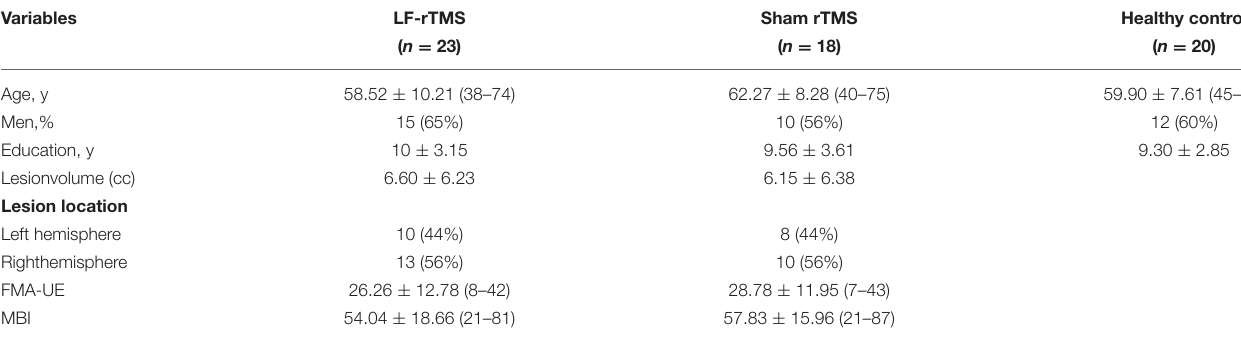
TABLE 1 | Demographic and clinical information of patients with stroke and healthy controls. Variables